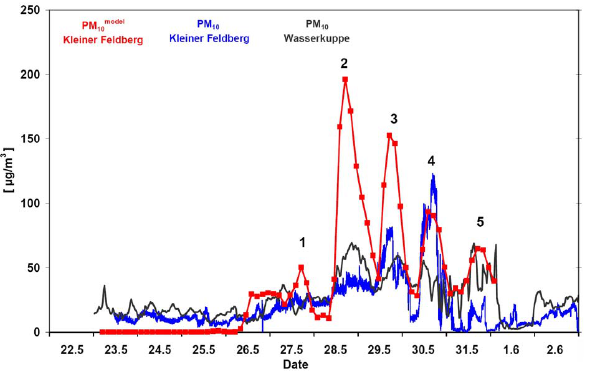
Fig. 7. Measured and modeled PM 10 mass concentration during the dust event at the Taunus Observatory: blue curve : PM 10 de- rived from APS size spectra of d p < 10µm; red cuve : PM 10 calcu- lated by DREAM model; black curve : PM 10 measured at moun- tain weather station Wasserkuppe 110km northeast of Observatory (HLUG 2008).